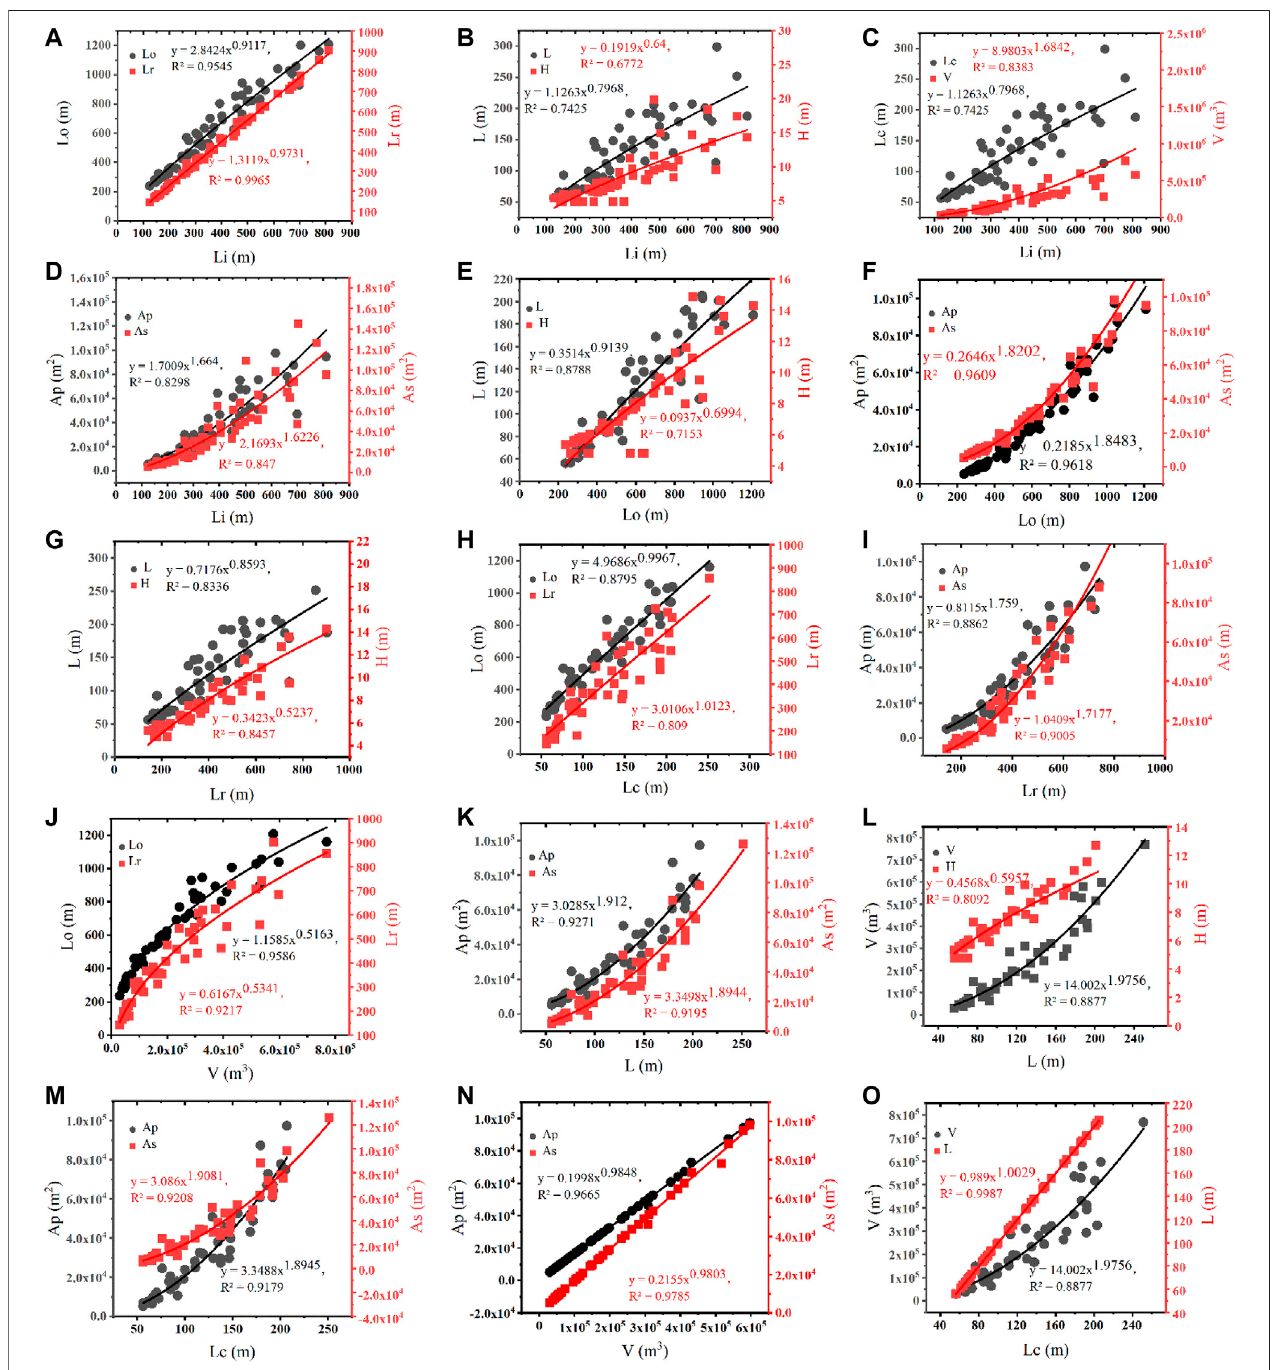
FIGURE 6 | Correlations between the various morphological parameters of the sand